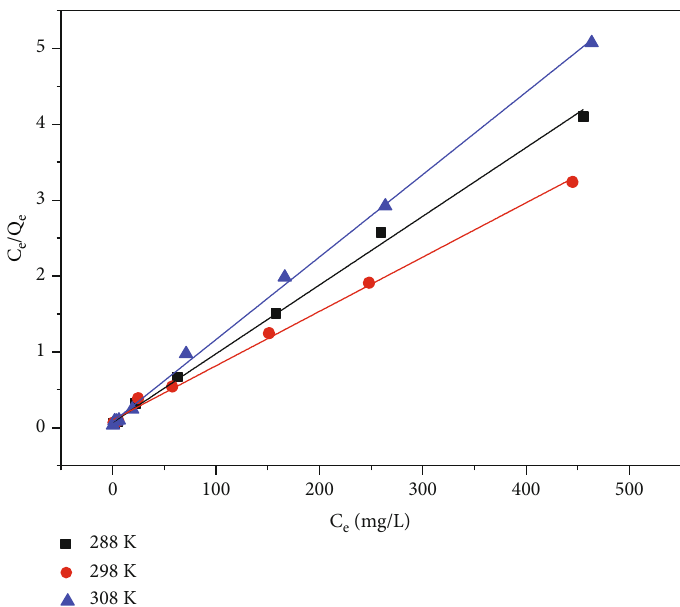
Figure 9: Langmuir isotherm for Cr (VI) removal on CSBT.